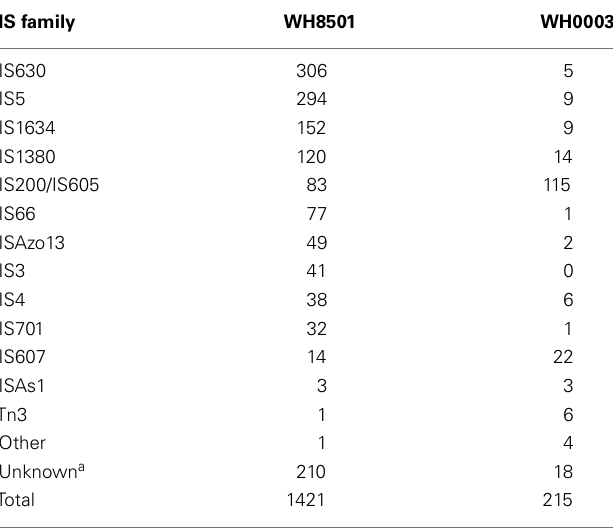
Table 3 |Transposase IS family distribution in both genomes.